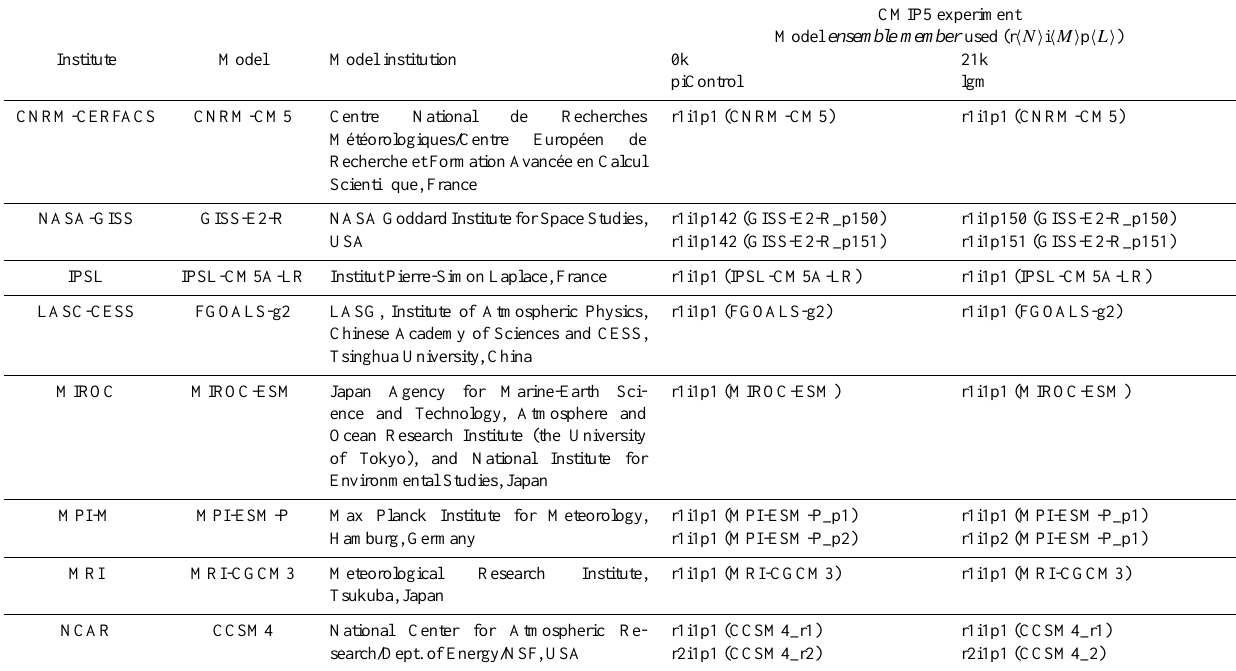
Table 1. List of all simulations used in this study (see Fig. 3). The ensemble member (r (cid:104) N (cid:105) i (cid:104) M (cid:105) p (cid:104) L (cid:105) ) formatted as shown below (e.g. “r3i1p21” with r for “realization”, i for “initialization method indicator” and p for “perturbed physics”) distinguishes among closely related simulations by a single model (Taylor et al., 2012). The reference given in brackets next to the ensemble number in columns 4 and 5 is the name of the simulation used in Fig.